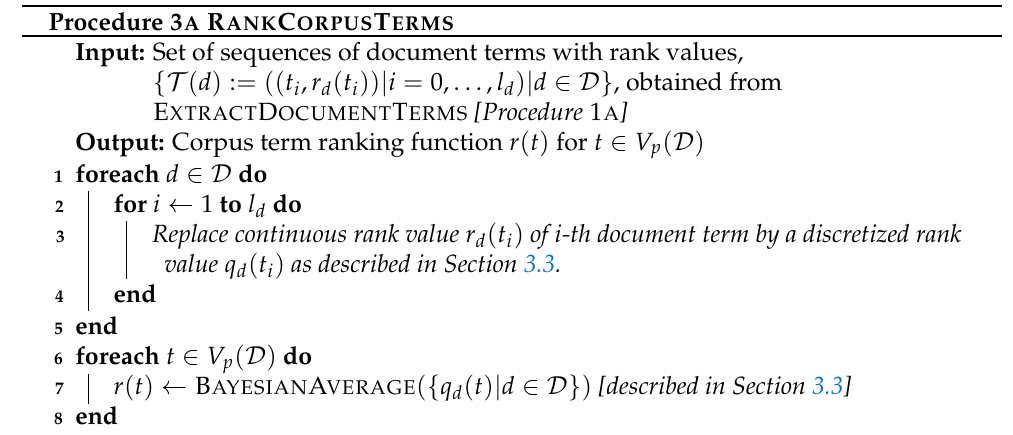
Procedure 3 A R ANK C ORPUS T